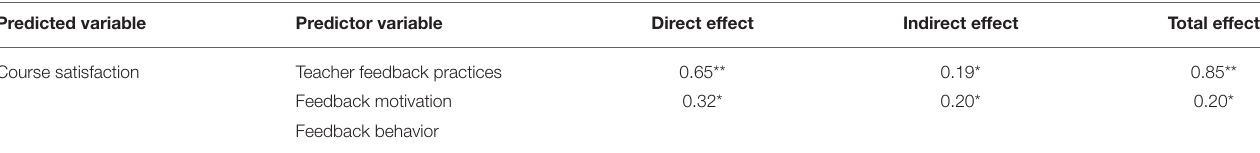
TABLE 4 | Unstandardized direct, indirect, and total effects for structural model. Predicted